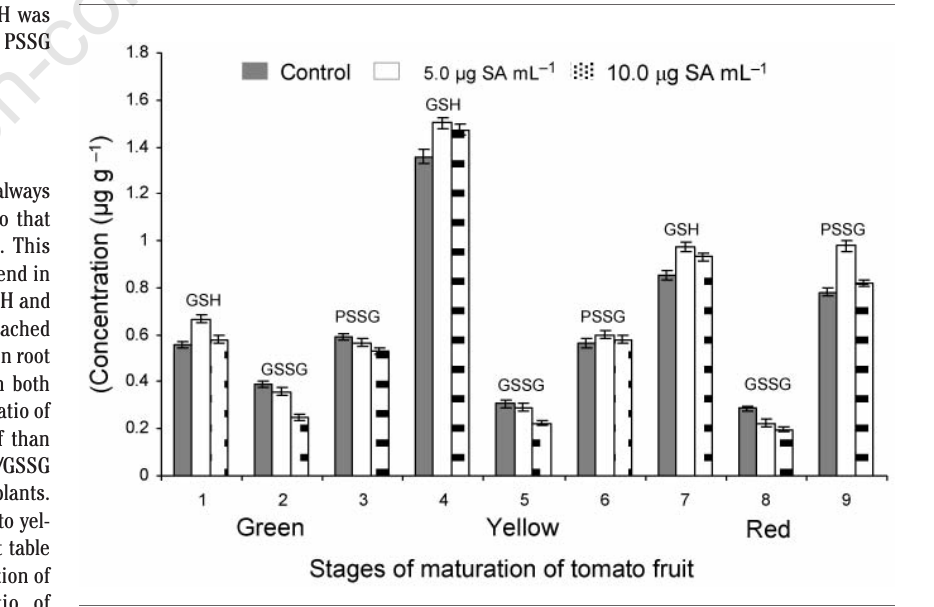
Figure 2. Free reduced (GSH), free oxidized (GSSG) and protein bound (PSSG) glu- tathione in tomato fruit as affected by foliar treatments of the transplants with SA (1, 2 and 3 = green, 4, 5 and 6 = yellow, 7, 8 and 9 = red